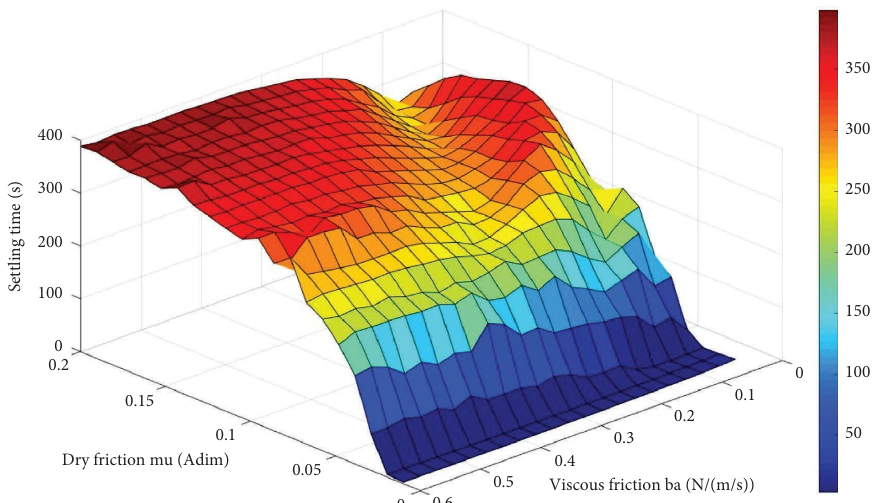
Figure 10: Settling time value for diferent values of μ and b